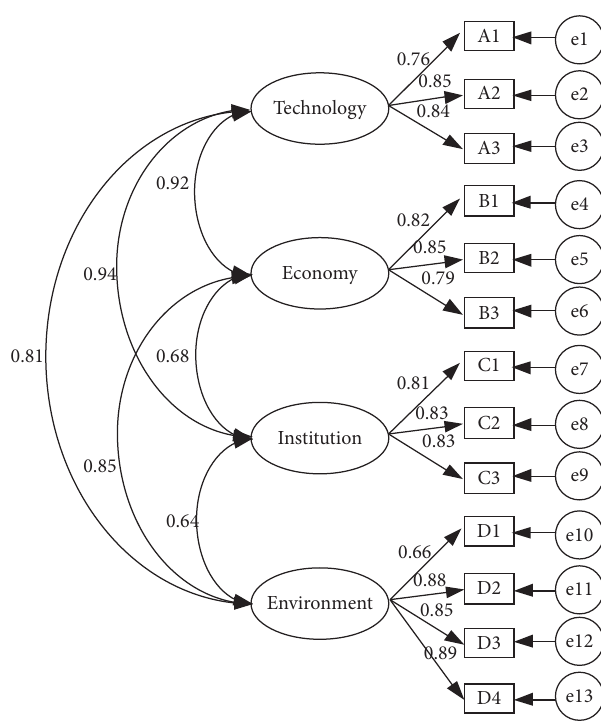
Figure 4: Standardized parameter estimation.